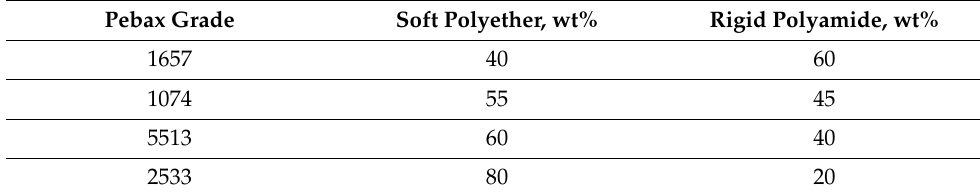
Table 1. Relative composition of the Pebax grades most used for gas separation. Pebax Grade Soft Polyether, wt% Rigid Polyamide, wt%